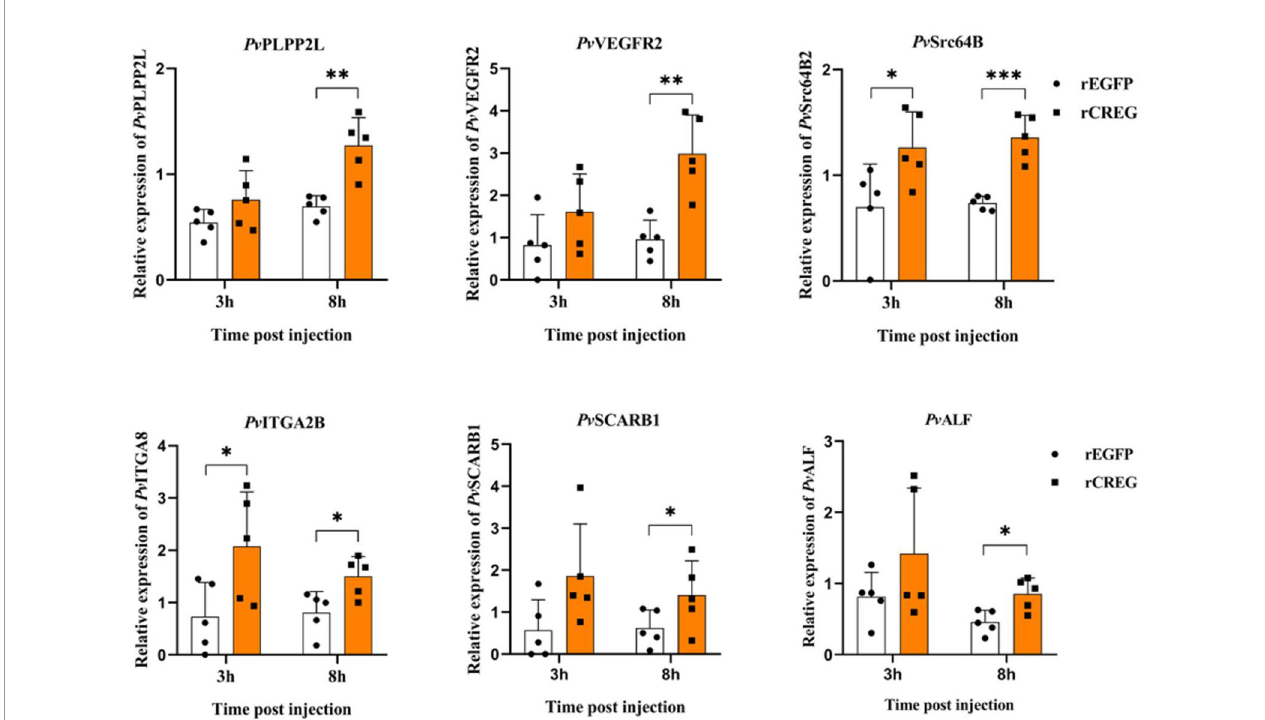
FIGURE 5 | Validation of differentially expressed genes (DEGs) by qPCR. To validate the transcriptome data, the relative gene expression levels of six selected DEGs were examined by qPCR. Each dot represents the test result of one experiment. * p < 0.05, ** p < 0.01, and *** p < 0.001 were calculated by two-tailed unpaired Student ’ s t -tests compared with the control (0 h, set as